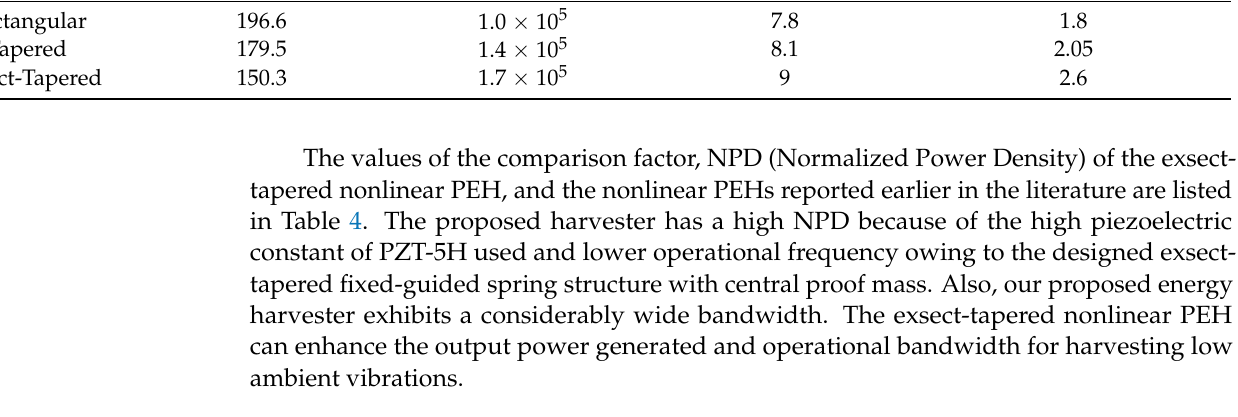
Table 4. Comparison of reported nonlinear wideband piezoelectric energy harvesters.